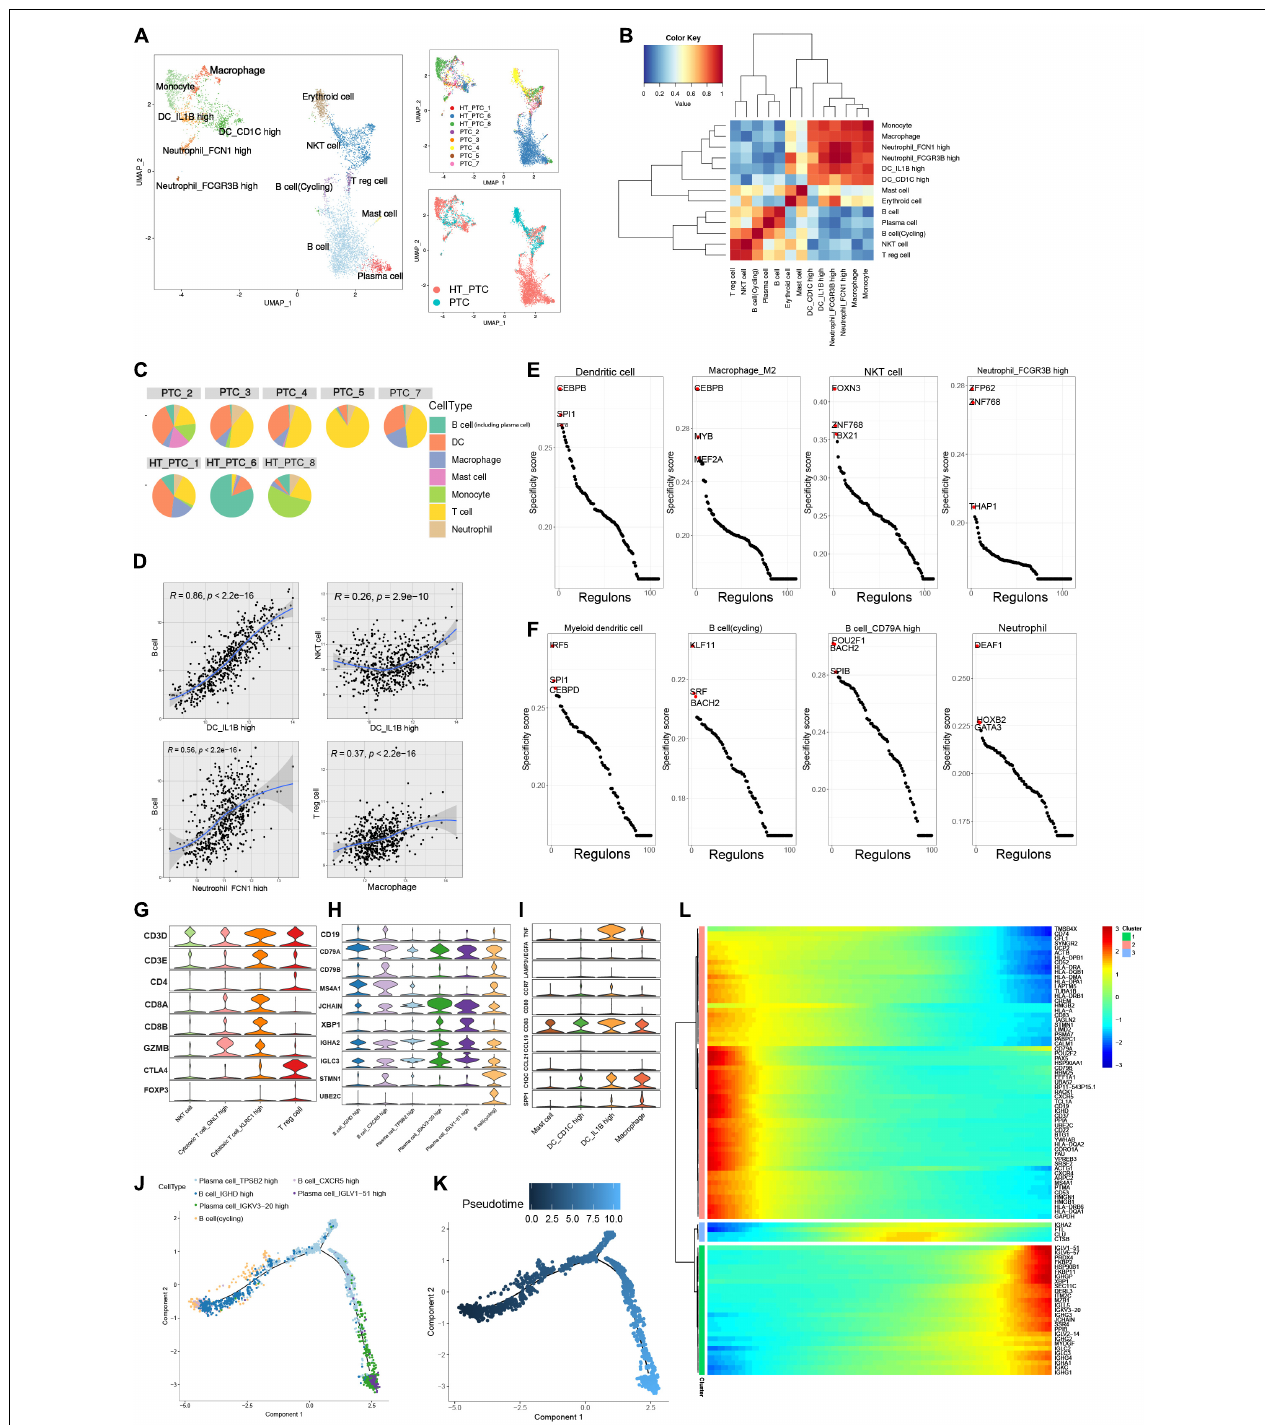
FIGURE 4 | Reclustering of tumor-infiltrating immune cells. (A) UMAP plots of immune cell subclusters in PTC colored by cell types, patient, and PTC types. (B) Cell–cell Spearman correlation network of immune cell subclusters. (C) Pie charts of cell-type fractions for each patient’s tumor-infiltrating immune cells. (D) Correlation between myeloid cells and lymphocytes subsets in the TCGA-THCA cohort. Coefficient was calculated with Spearman correlation analysis. (E) Rank of the cell type–specific regulons in immune cells from PTC patients without concurrent HT. (F) Rank of the cell type specific regulon in immune cells from PTC patients with concurrent HT. (G) Violin plot of marker genes in T-cell subclusters. (H) Violin plot of marker genes in B-cell subclusters. (I) Violin plot of marker genes in myeloid cell subclusters. (J) Pseudotime trajectory of B-cell subclusters using monocle2. (K) Color-coded pseudotime of B-cell subclusters; the start point is dark blue. (L) Heatmap of the top DEGs expression levels in three divided clusters from pseudotime trajectory.